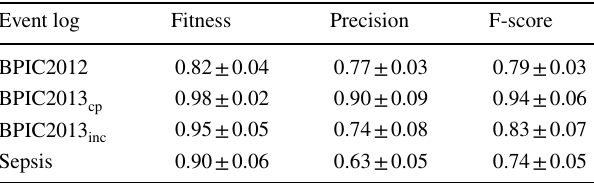
Table 6 The experimental results of performing PSOMiner on four real event logs Event